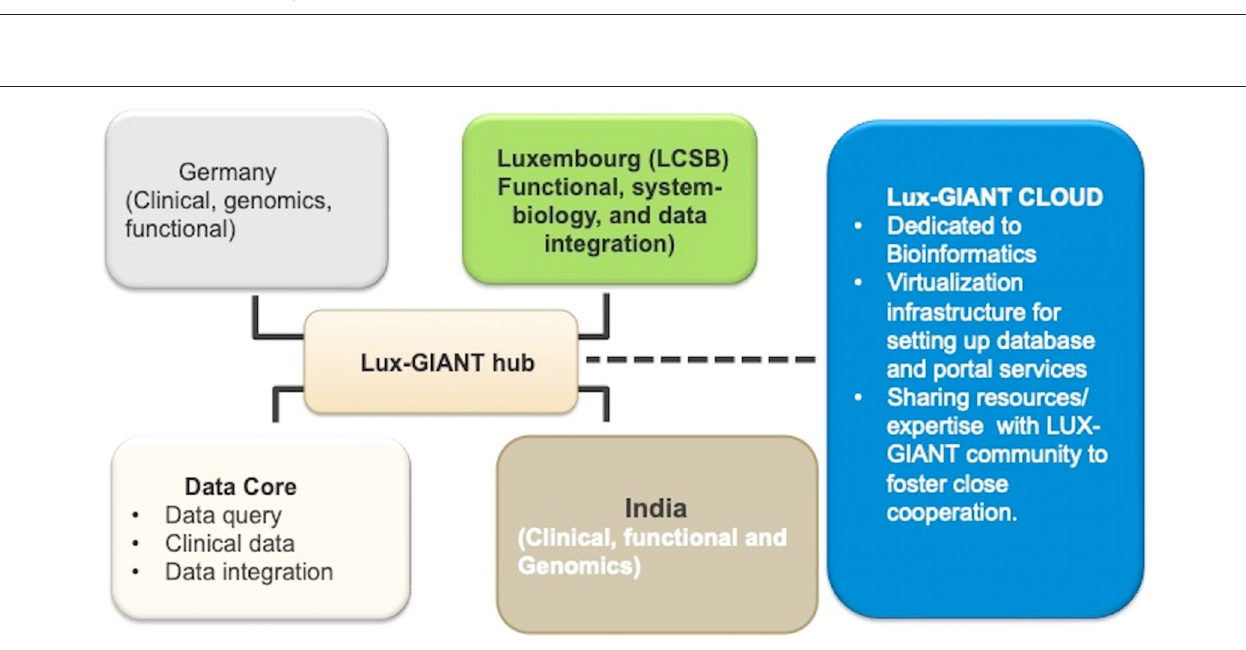
Frontiers in Neurology | www.frontiersin.org